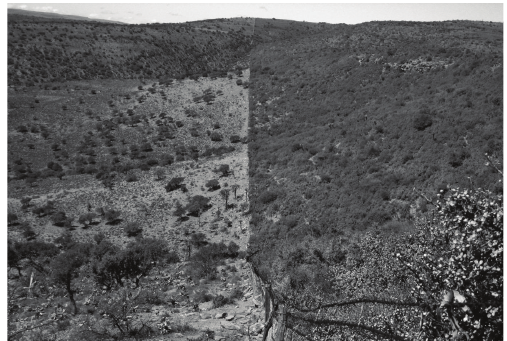
Figure 1: High-contrast land cover characteristics are found at fence lines between pasture and game farms in the Eastern Cape Province, South Africa. The pasture farm on the left side is highly degraded whereas the land on the right side is only slightly influenced and is nearly pristine Thicket shrub vegetation. The consequences of unsustainable land use can be detected and monitored using